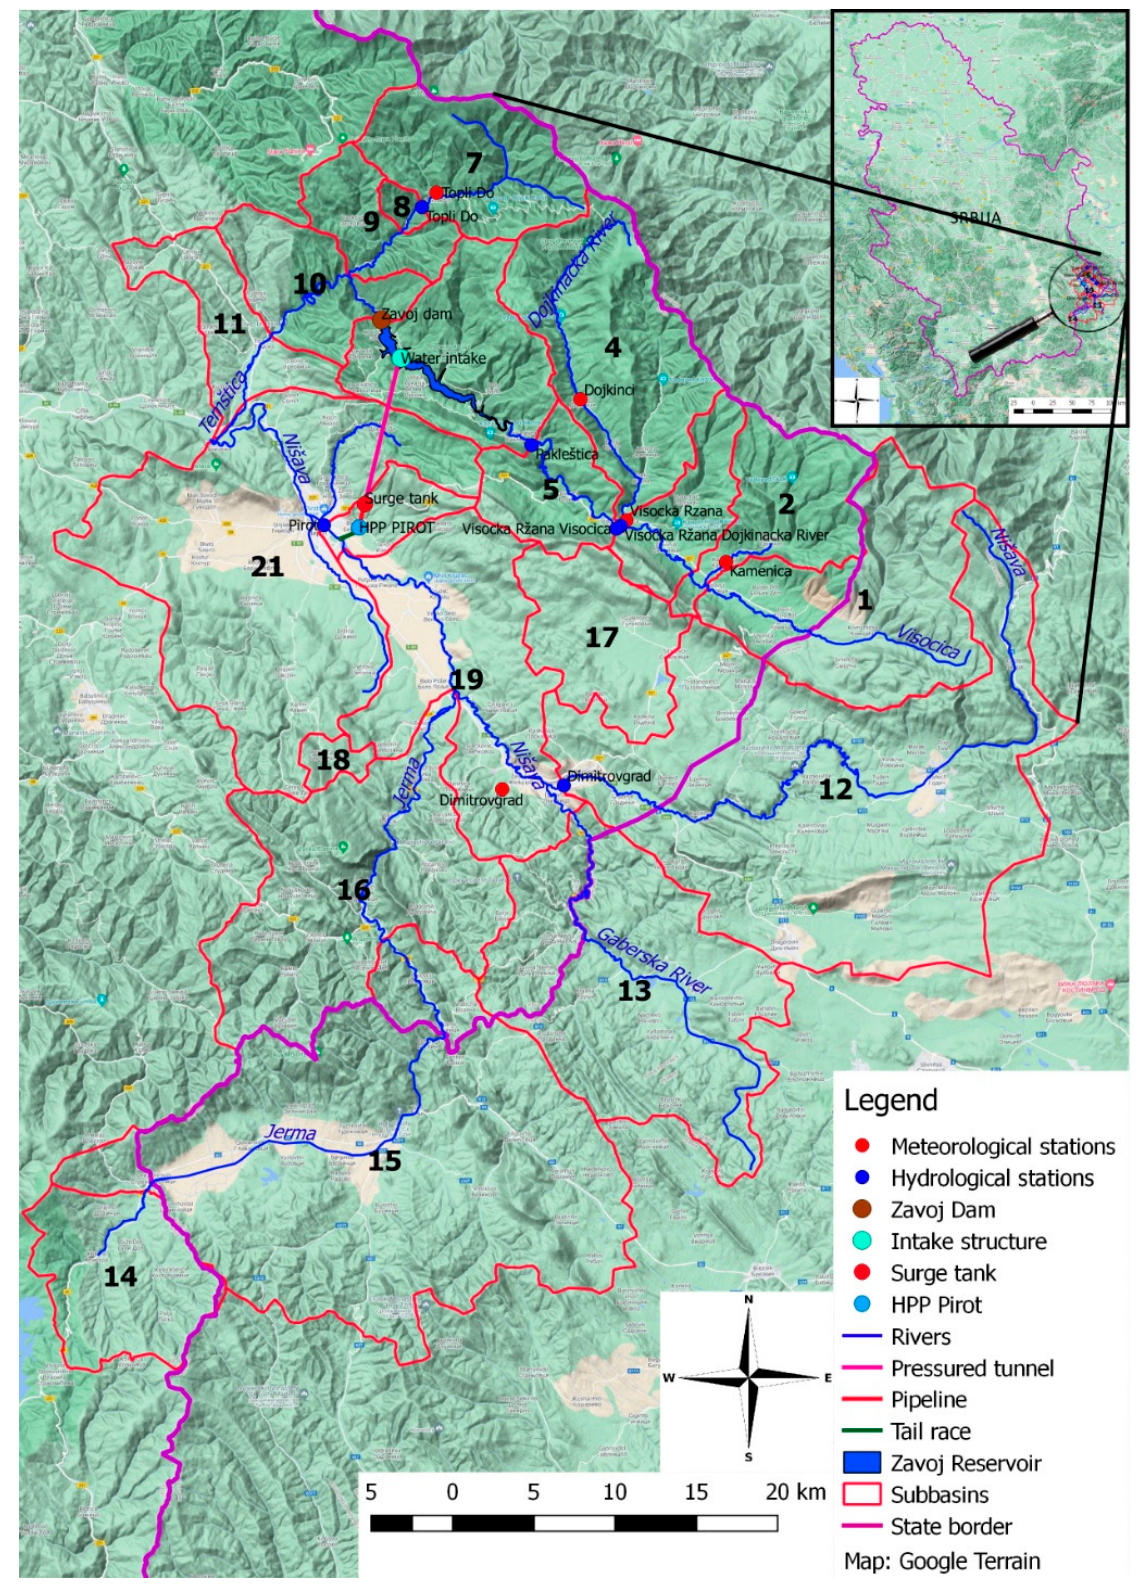
Figure 3. Delineation of subbasins in a hydrological model on a google terrain map.